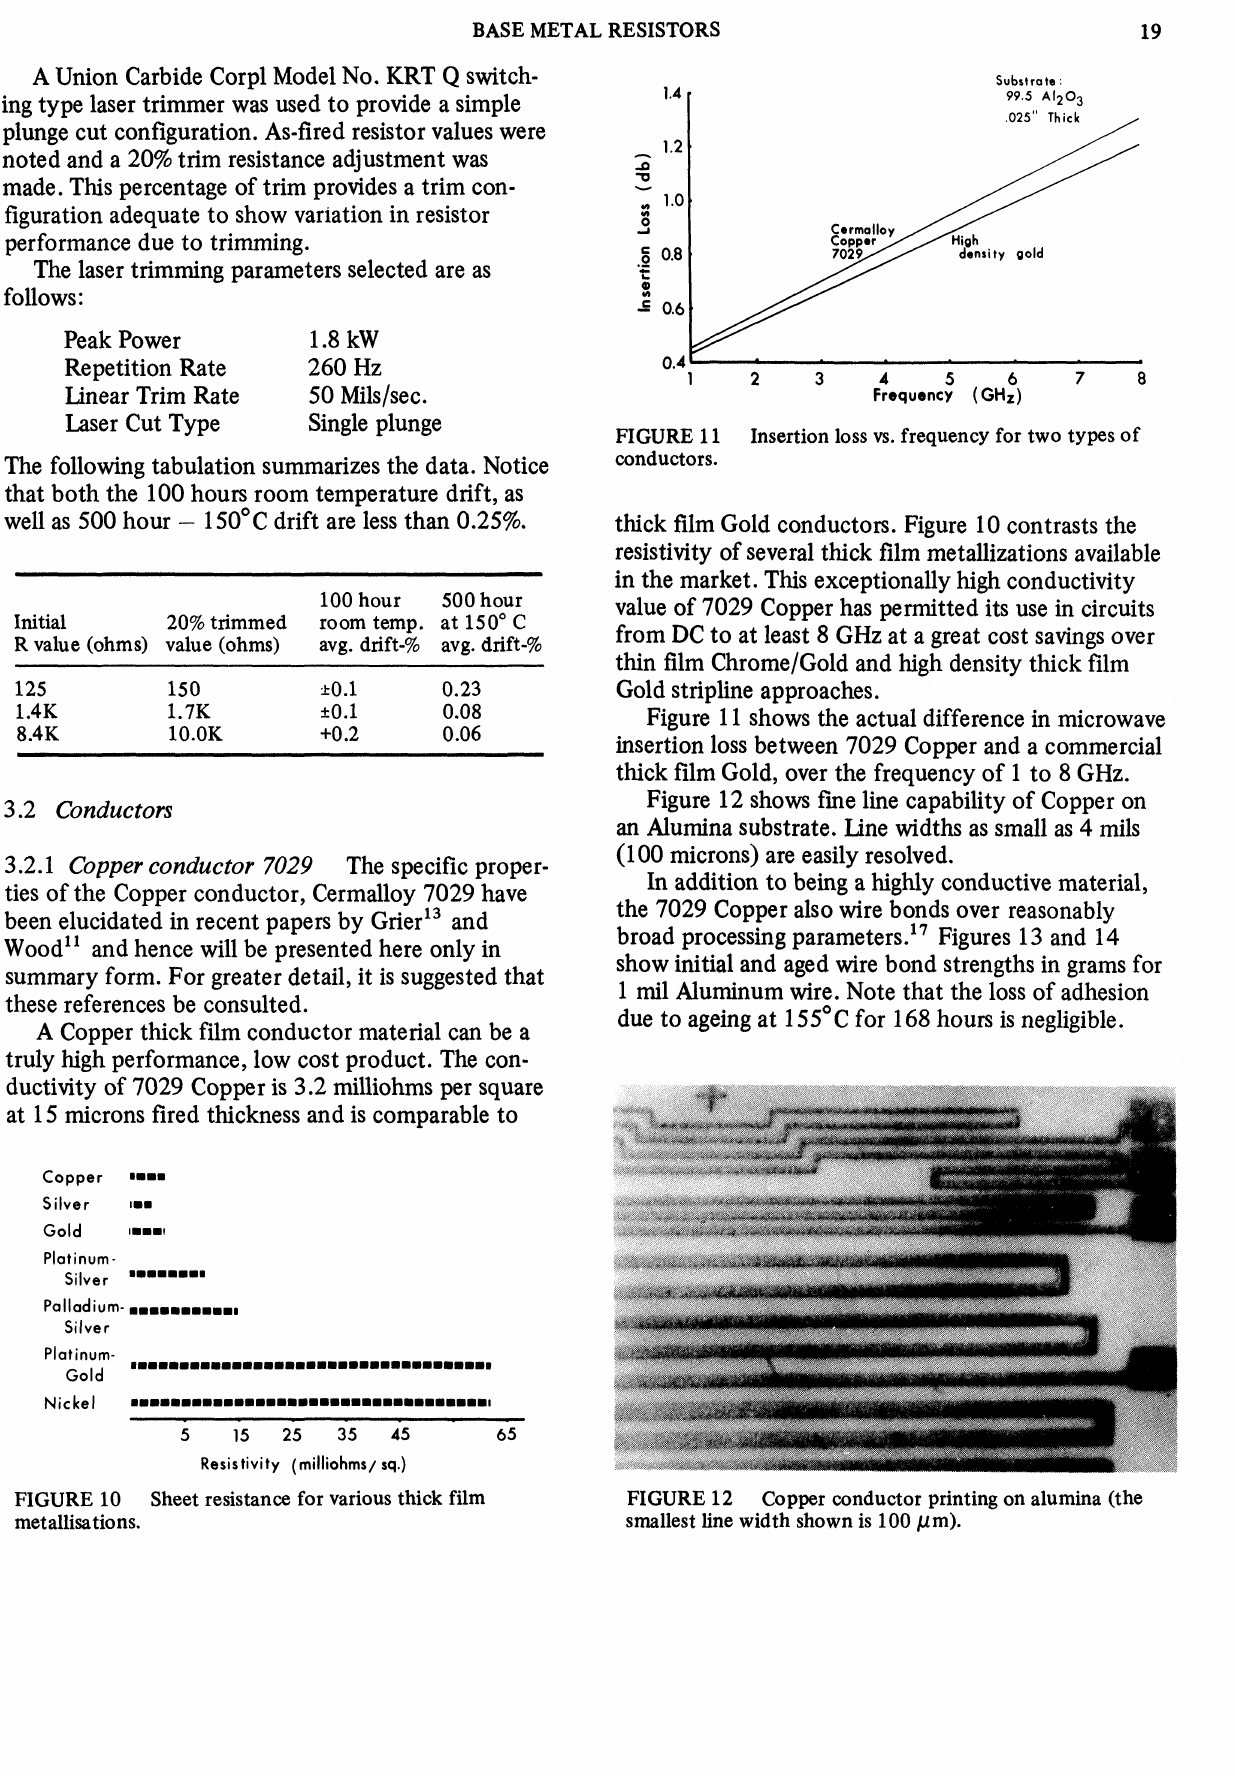
FIGURE 12 Copper conductor printing on alumina (the smallest line width shown is